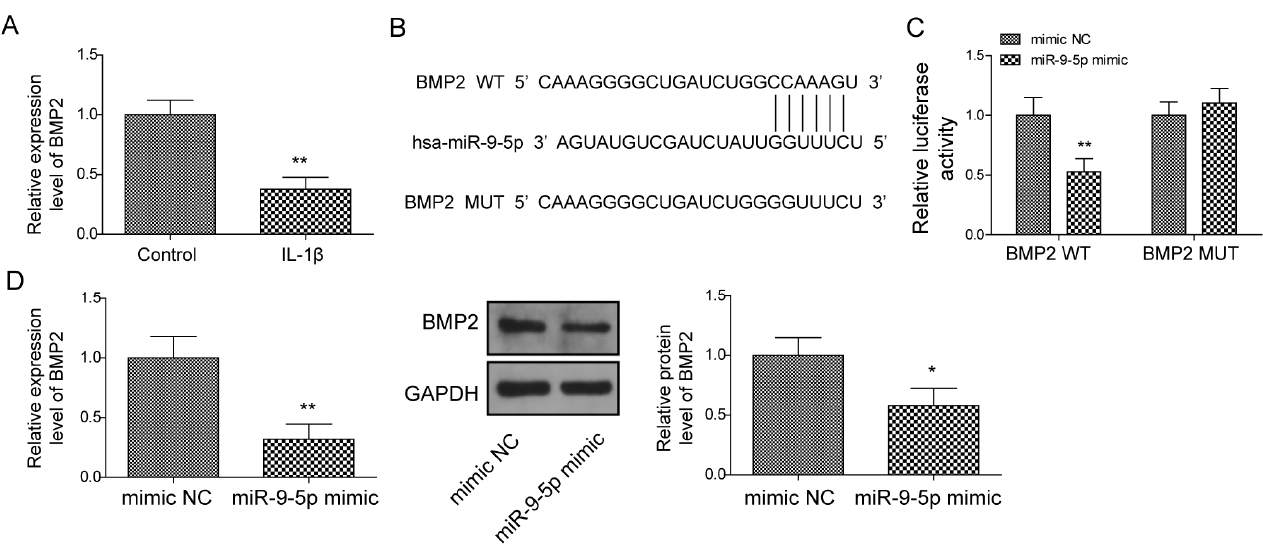
Figure 6. BMP2 is identified as a target of miR-9-5p. ( A ) BMP2 expression under IL-1 β stimulation using qPCR. ( B ) The potential site of miR-9-5p located in BMP2 by starBase. ( C ) The relationship between miR-9-5p and BMP2 via dual luciferase reporter gene assay. ( D ) BMP2 expression by qPCR and Western blot. Data were estimated as mean ± SD. * p < 0.05, ** p < 0.01.